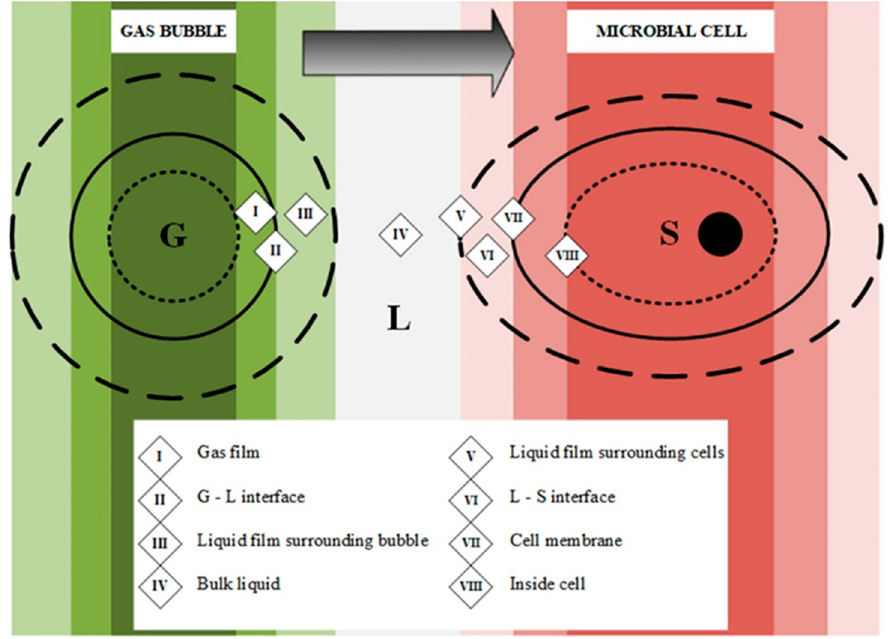
Figure 4. Steps involved in gas transfer from gas bubble to cell .